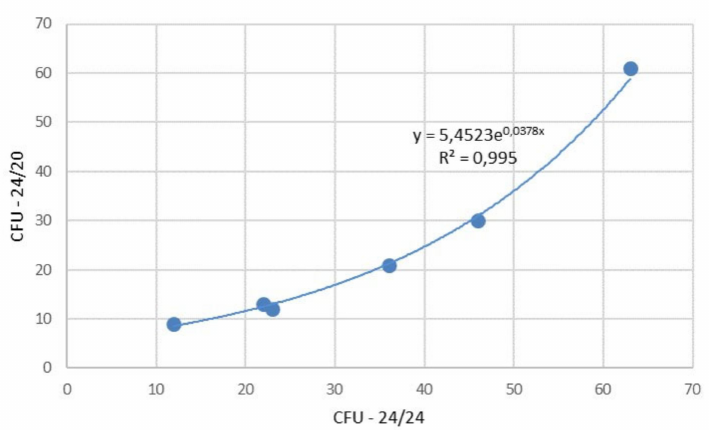
Figure 9. Values of Ratio CFU in correlation of densities 24 / 24 threads and 24 / 20